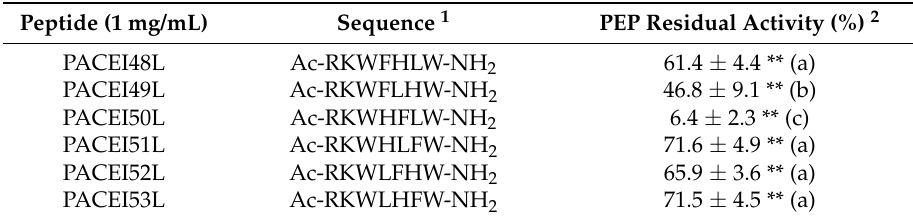
Table 3. Effects of heptapeptides (PACEI) on prolyl endopeptidase (PEP) activity. Peptide (1